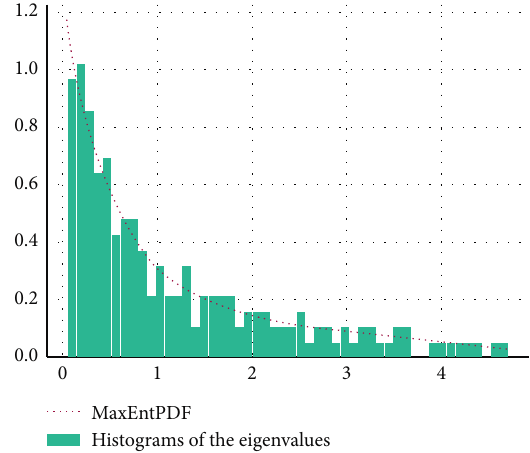
Figure 1: d � 200, n � 100, alpha � 0.5, and beta � 0.3.